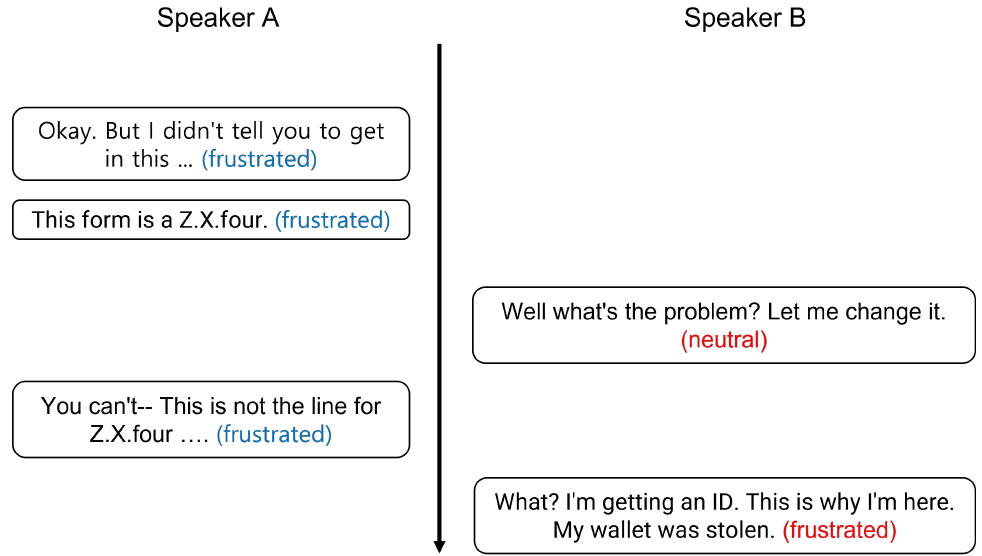
Figure 2. An example of inter-speaker dependency context. As shown in the figure, Speaker B’s emotional state shift from neutral to frustrated is triggered by Speaker A’s